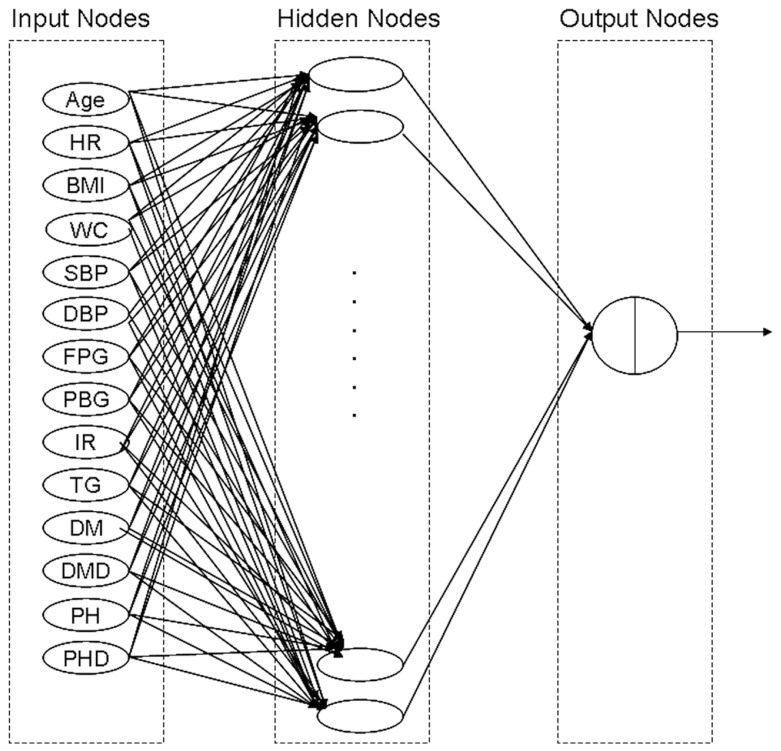
Artificial neural network model showing input variables (nodes), hidden nodes, and connection weights with output node for data on CA dysfunction.The ANN model including 14 input nodes, 18 hidden nodes and 1 output node. Data from a total of 2077 patients had been used to ANN analysis. BMI- Body mass index, WC-waist circumference, SBP- systolic blood pressure, DBP- diastolic blood pressure, FPG- fasting plasma glucose, PBG- plasma blood glucose, IR-insulin resistance, TG- triglyceride, UA- uric acid, HR-heart rate, PH- Hypertension, DM- Diabetes, PHD- Hypertension duration, DMD- Diabetes duration.